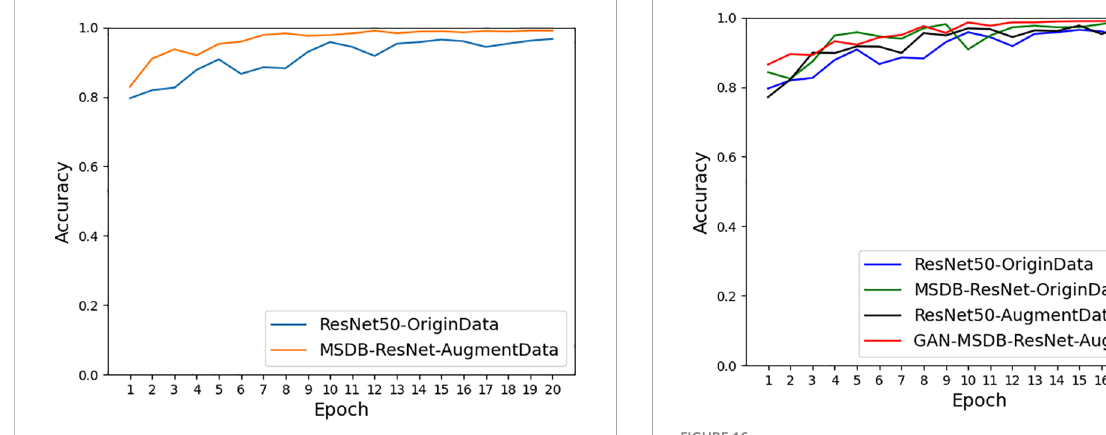
FIGURE 16 All approaches of accuracy curve.